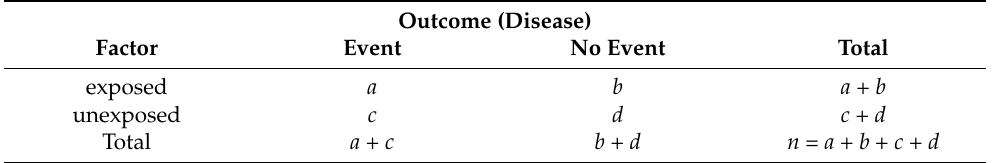
Table 1. Notation for entries in a 2-by-2